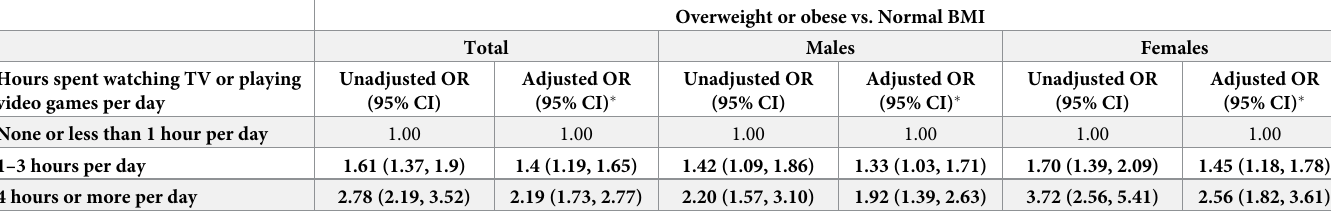
Table 2. Results of logistic regression analysis of the association between time spent watching TV or playing video games and BMI in adolescents. Overweight or obese vs. Normal BMI